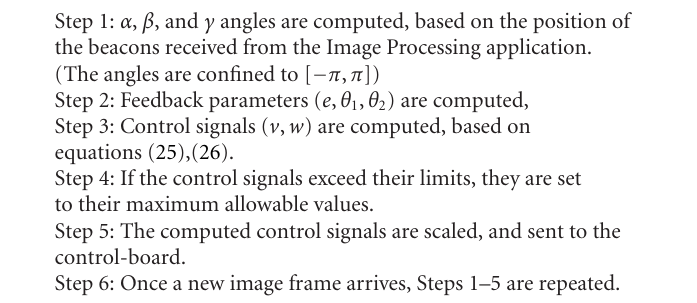
Algorithm 2: The control algorithm to steer the robot.